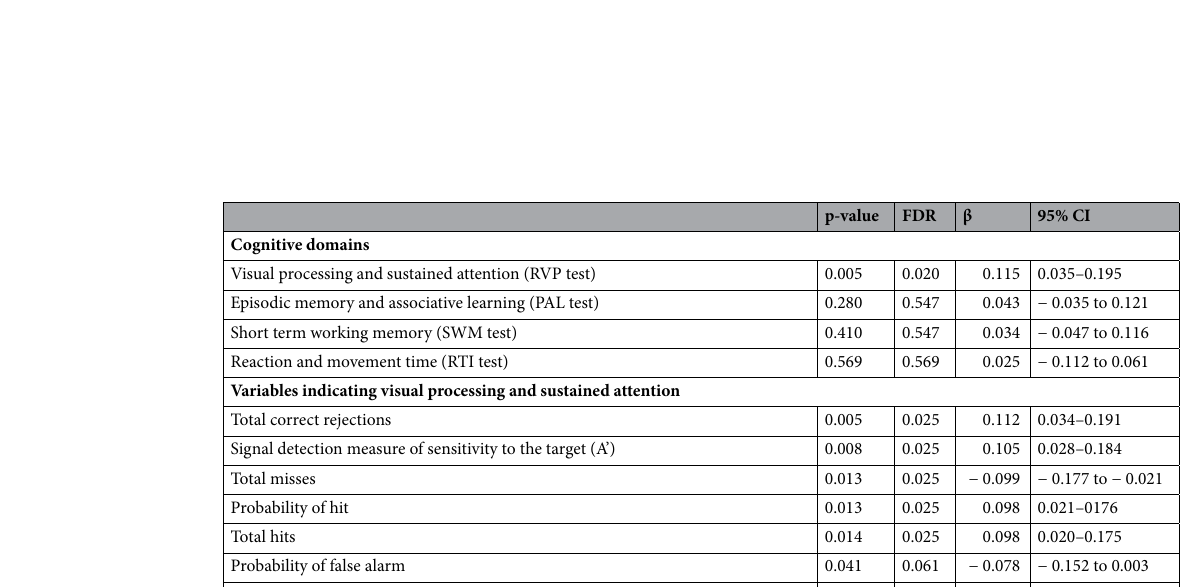
Signal detection measure of the strength of trace required to elicit a response